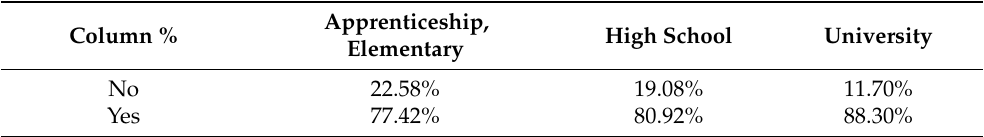
Table 3. Columnar relative frequencies (variables online grocery shopping and highest education of